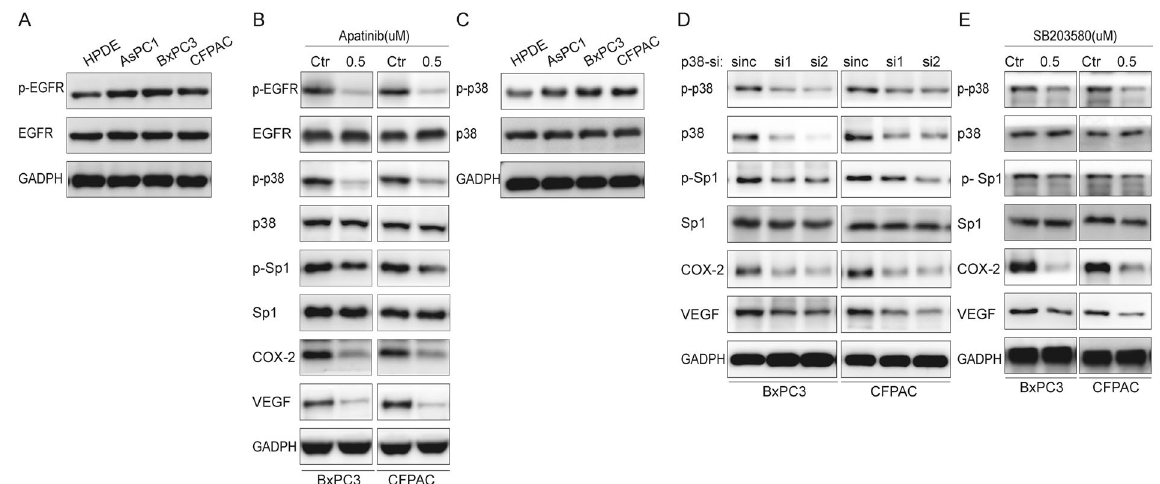
Figure 5. EGFR/p38-MAPK signalling functions upstream of Sp1-driven COX-2 induction. ( A ) The genetic profile of EGFR in PDAC cells as detected by Western blot. ( B ) p38, Sp1, COX-2 and VEGF expression upon pharmacological inhibition of EGFR with afatinib. ( C ) The genetic profile of p38 in PDAC cells as detected by Western blot. ( D,E ) The expression of Sp1, COX-2 and VEGF when p38 was inhibited using pharmacological (SB203580) or siRNA